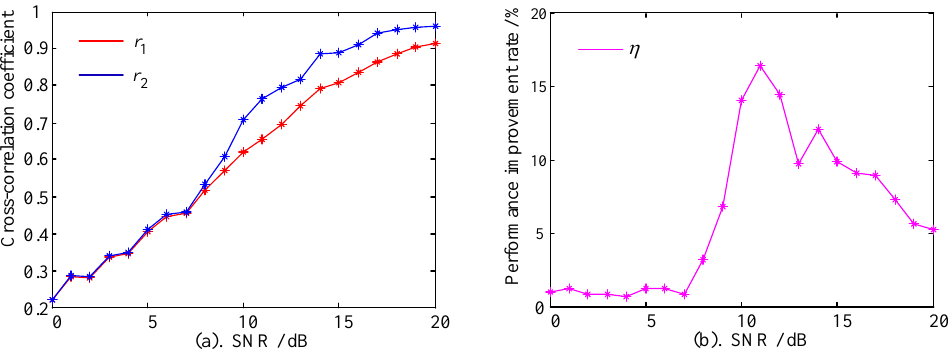
Figure 9. Comparison of the algorithm performance at different SNRs. ( a ) The cross-correlation coefficient curve comparison. ( b ) The SRC algorithm performance index curve.